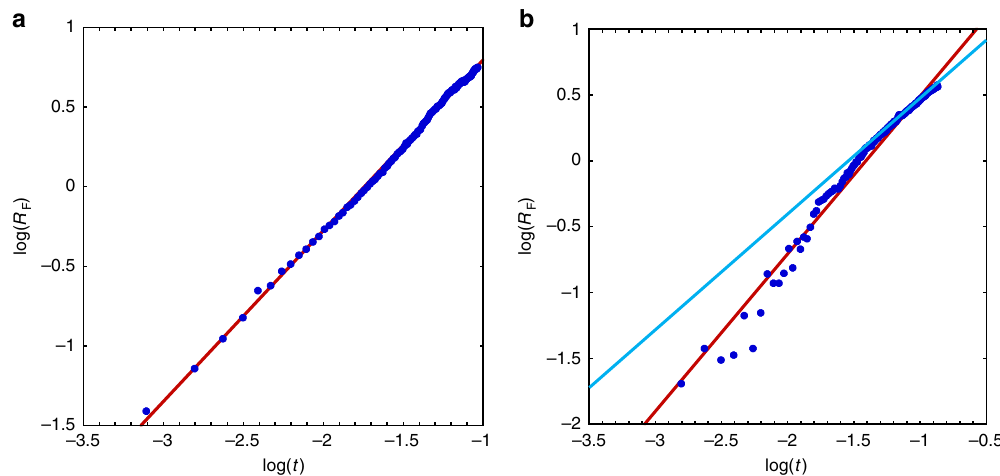
Fig. 7 Position of the leading edge of the fi lm during the expansion stage as a function of time. a Pulsation P 1 ; b pulsation P 4 . In a , the slope of the red line is 1.1. In b , the slopes of the red and blue lines are 1.2 and 0.82, respectively